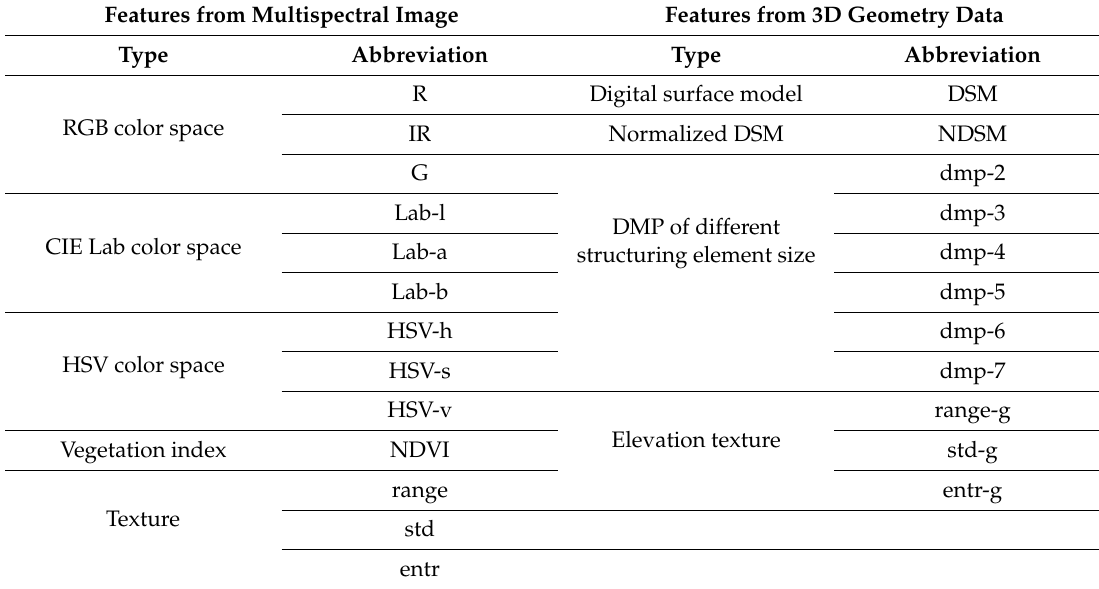
Table 1. Different types of features and their abbreviations used in this work.